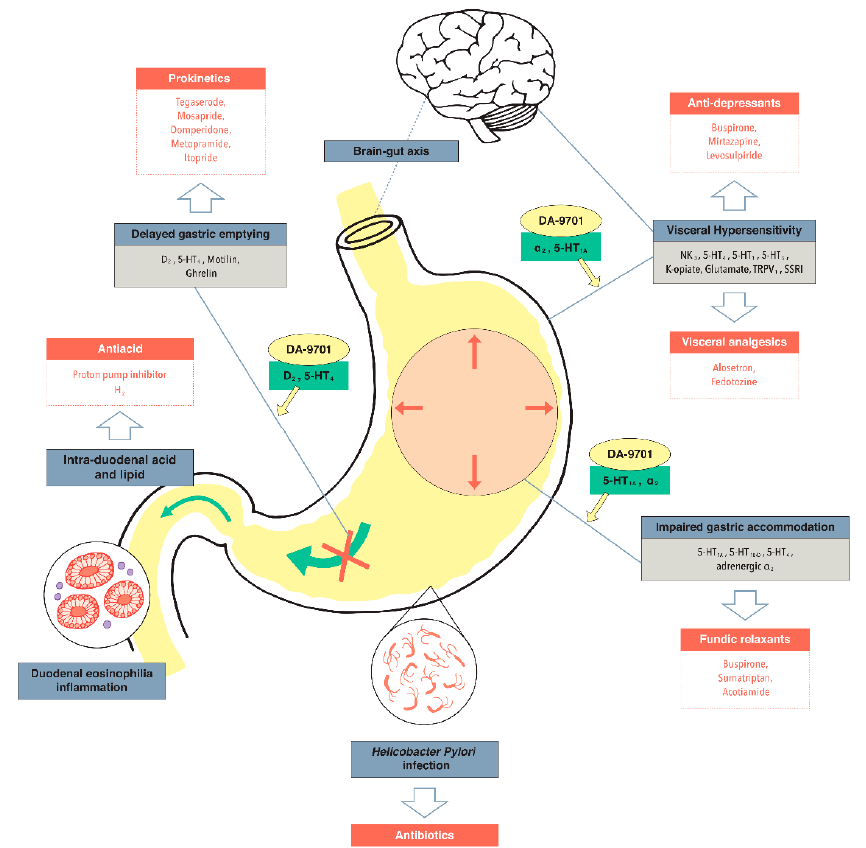
Figure 1. Major drug targets associated with pathophysiology of functional dyspepsia and current drugs. Targets of DA-9701 are presented. drugs. Targets of DA-9701 are